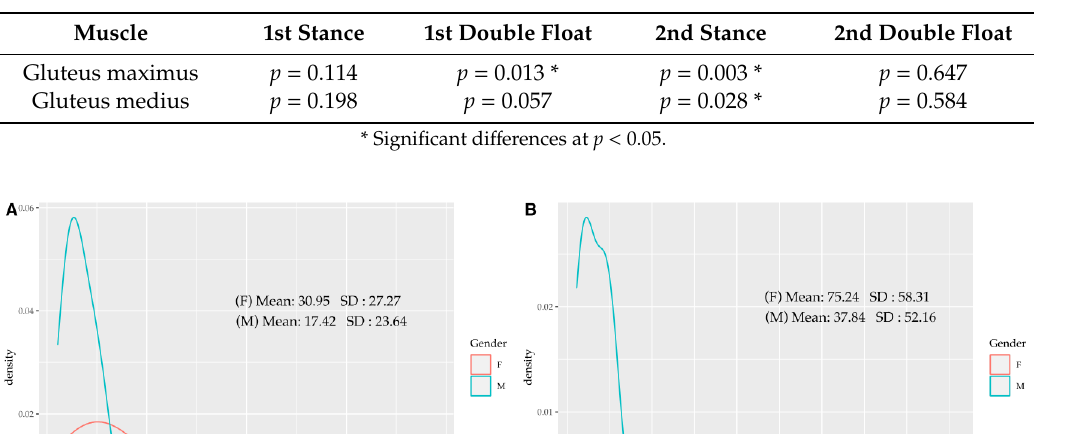
Table 5. The p -values of the mean in the muscles with significant di ff erences between the sexes in di ff erent phases.